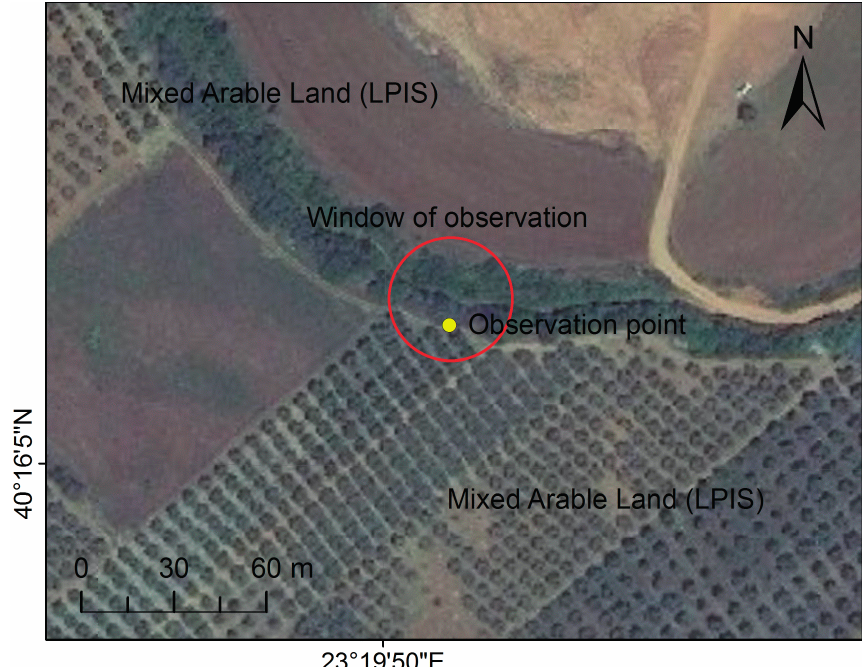
Figure 8. A particular case in Chalkidiki, where the extended window of observation (red circle) covers partially natural vegetation and agricultural land (olive trees and arable land). The surface is classified as “Shrubland without tree cover” (D20) by the LUCAS surveyors, whereas for LPIS is considered as “Mixed Arable Land”. The point of observation was found inside the extended window of